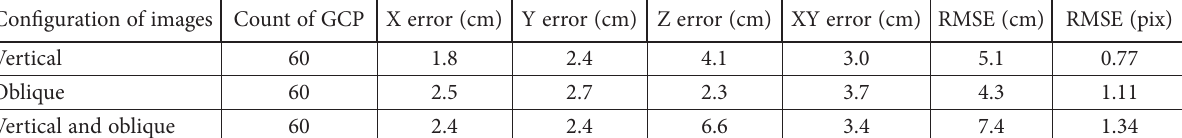
Table 1. Detailed distribution of model fitting errors on ground control points for the analyzed image variants